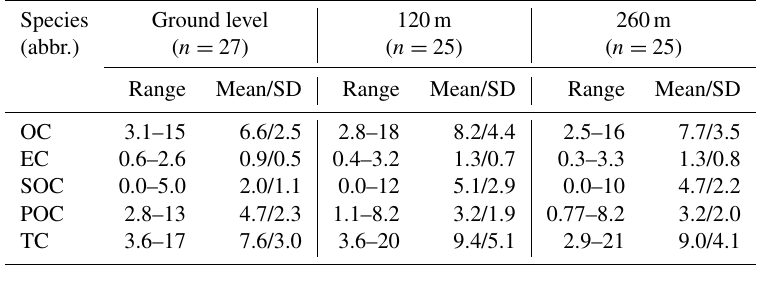
Table 1. Vertical concentrations (µgm − 3 ) of OC, EC, SOC, POC and TC in PM 2 . 5 aerosols collected at Beijing.